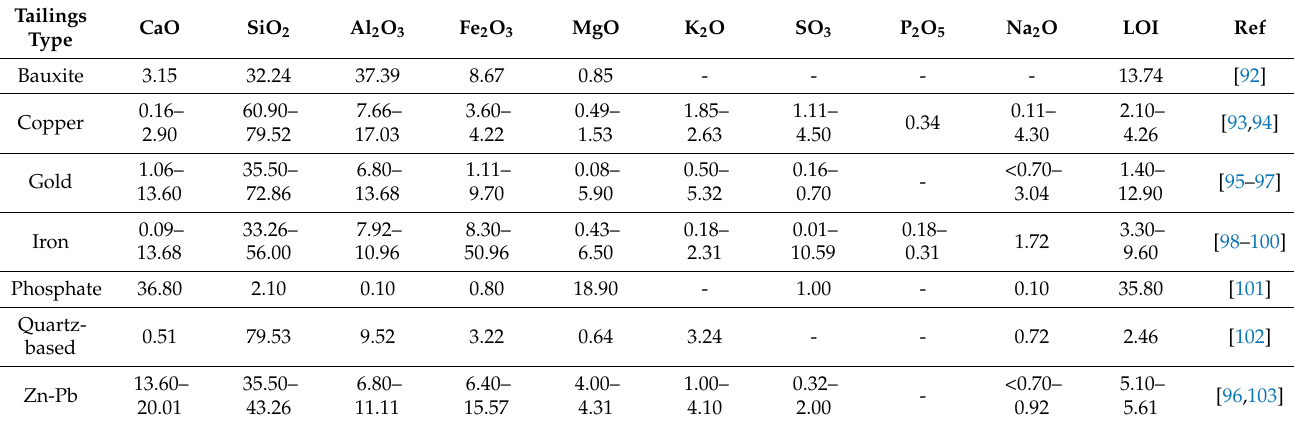
Table 5. Chemical composition of various mine tailings.